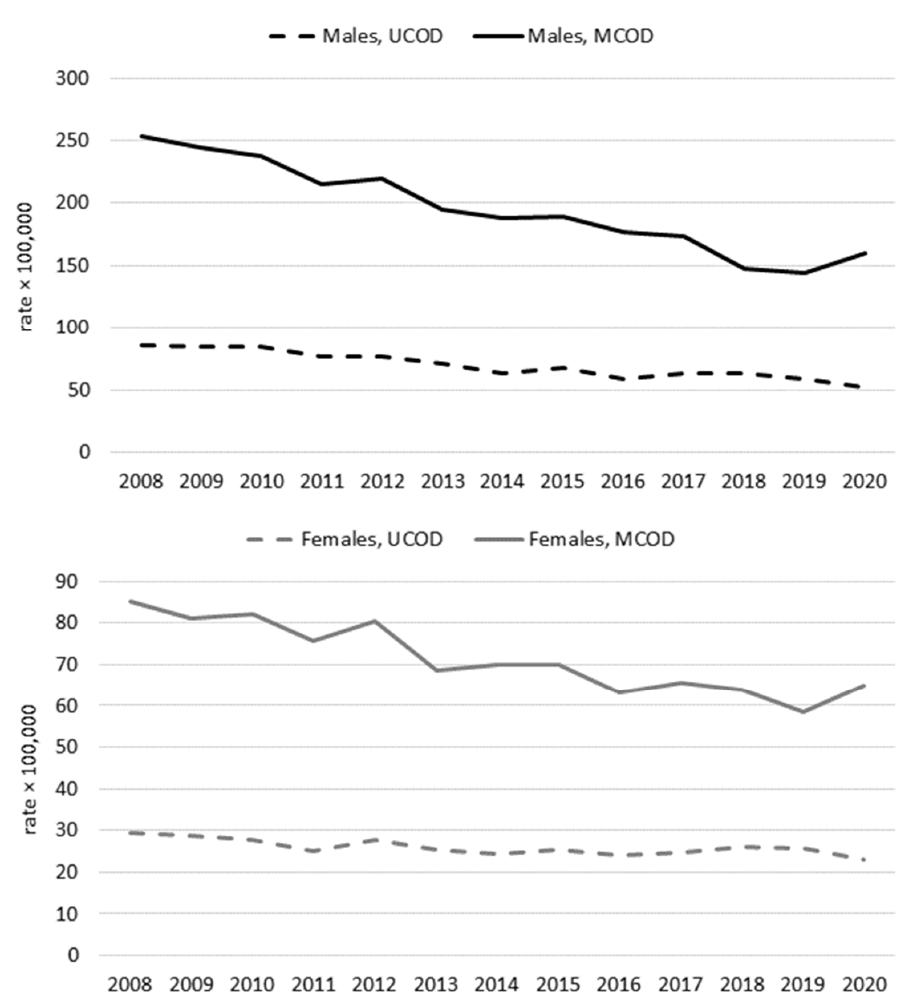
among women by the joinpoint analysis that identified two distinct pre-pandemic trends, with rates declining in 2008–2016 (APC − 2.3%, 95% CI − 3.8%, − 0.8%), followed by a non-significant increase in 2016–2019 (APC +3.0%; 95% CI − 4.0%, +10.5%). A similar overall pattern, but with a non-significant change in trend, was present among men.